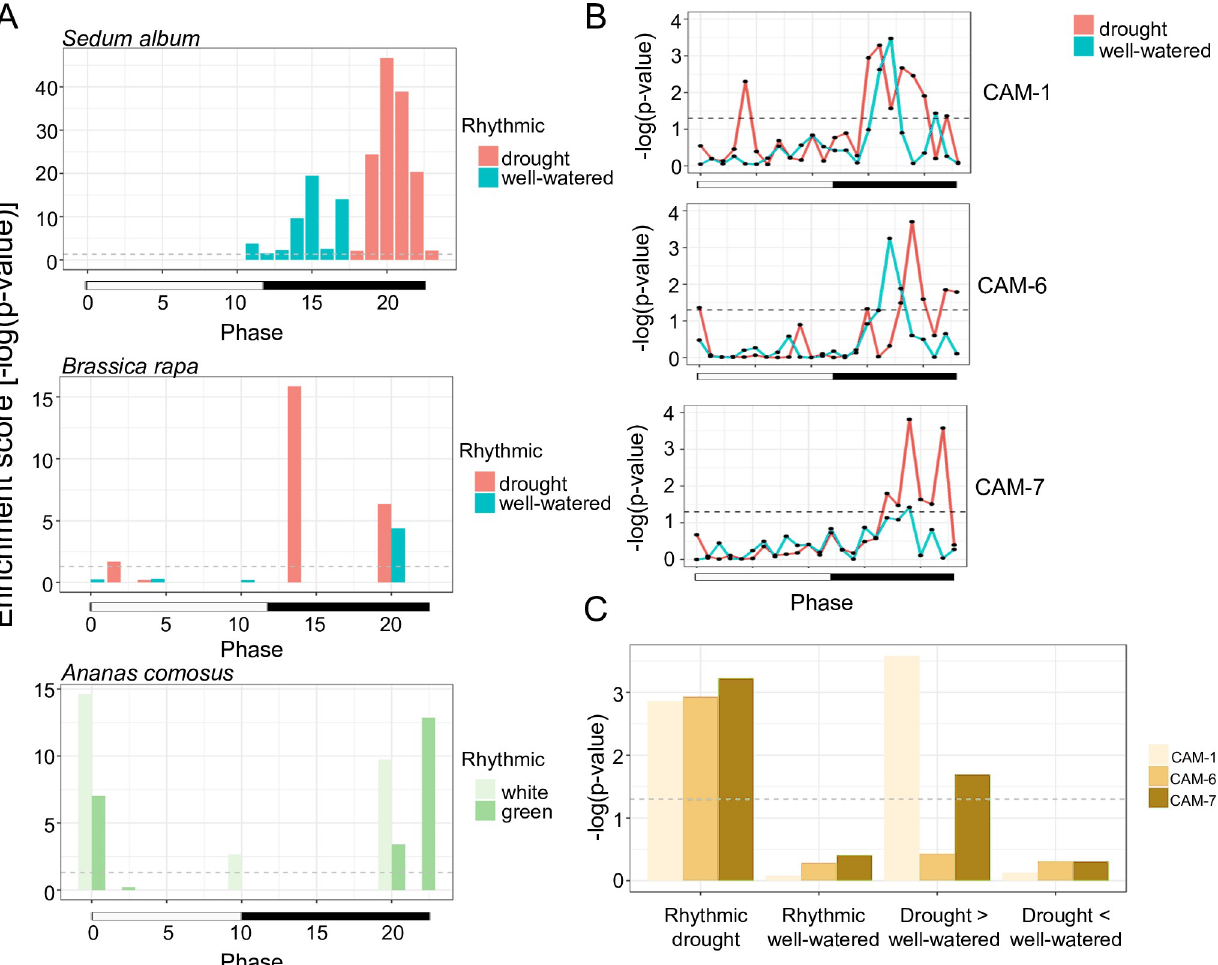
Fig 4. CAM induced phase shift and identification of novel drought cycling cis -elements. (A) Phase-specific enrichment of cycling genes in well- watered or drought conditions in S . album and B . rapa , and cycling genes in photosynthetic and non-photosynthetic leaf tissue of A . comosus . (B) Enrichment of three novel drought/CAM-specific cis -elements in each phase under well-watered and drought timecoruses of S . album . (C) Enrichment analysis of novel elements in each gene category. A significance line ( p -value of 0.05) is plotted as a dashed